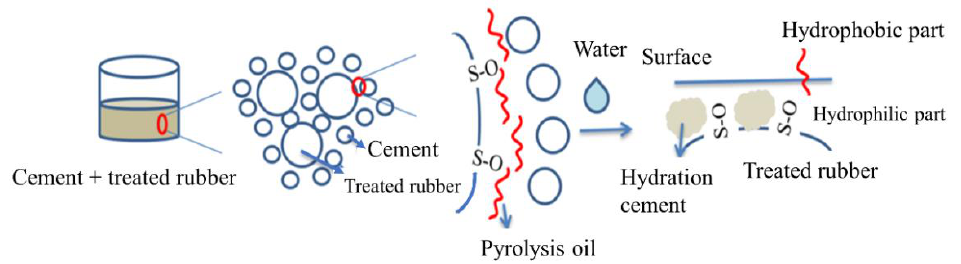
Figure 13. Possible mechanism of the hydrophobic cement paste. Pyrolysis oil has a long carbon chain hydrophobic part and a short carbon chain hydrophilic group.